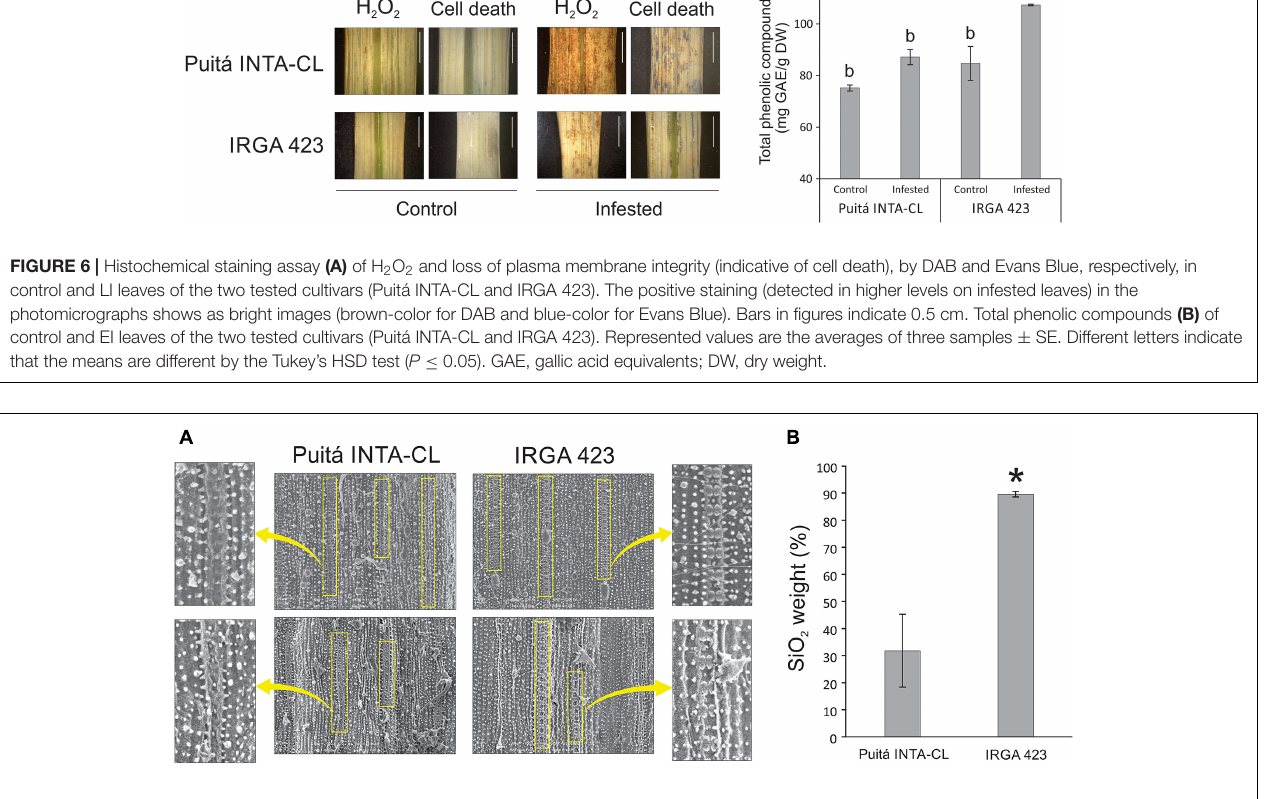
FIGURE 7 | Microscope observation of amorphous silica cells and SiO 2 quantification. (A) SEM of the infested leaf surfaces (adaxial face) from susceptible Puitá INTA-CL and tolerant IRGA 423 cultivars, highlighting the amorphous silica cells. (B) Quantification of SiO 2 using SEM. Figures in (A) are representatives of 10 analyzed leaf surfaces from each cultivar. Represented values in (B) are the averages of 10 samples ± SE. Mean values with one asterisk are significantly different as determined by the Student’s t -test ( P ≤ 0.05). DW, dry